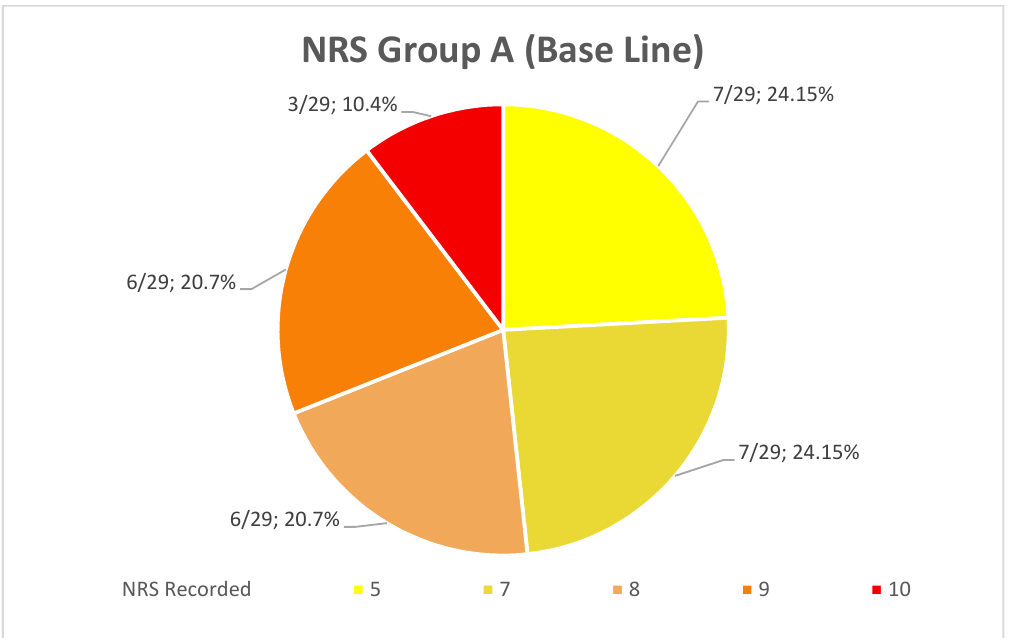
Figure 11. Distribution (numerical and percentage) of the NRS recorded in patients of Group A immediately after surgery.